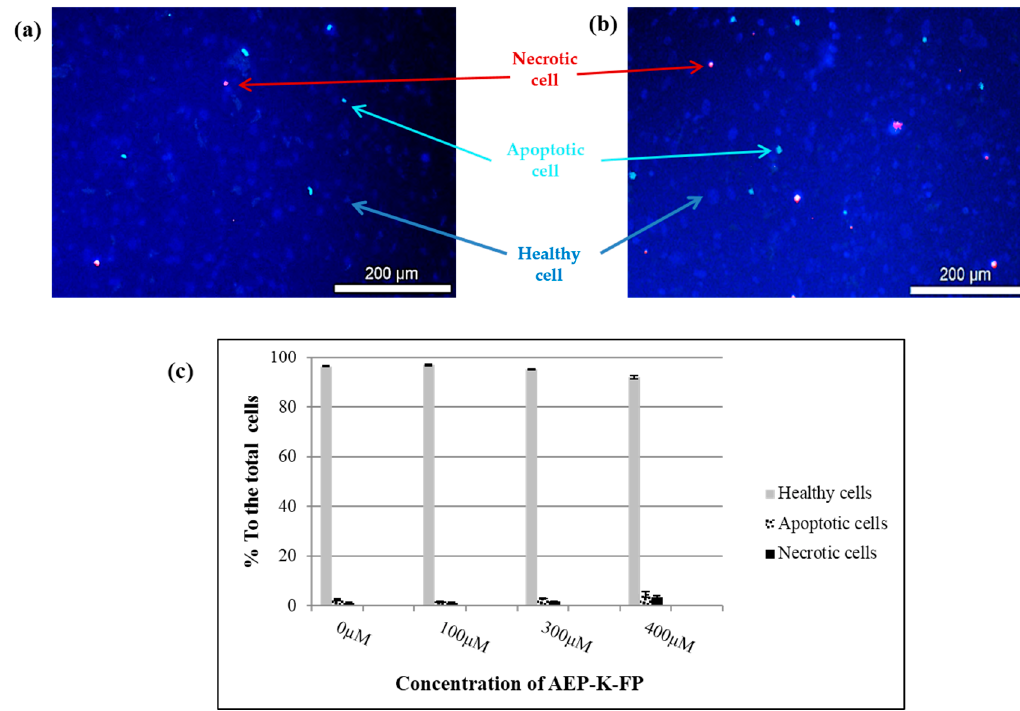
Figure 5. Examples of microscopic pictures after HPI staining. ( a ) Untreated cells (0 µ M). ( b ) AEP-K-FP (400 µ M). The blue cells represent the healthy living cells while the bright blue refers to apoptotic cells, and the red is necrotic cells. ( c ) The percentage of healthy, apoptotic, and necrotic cells to the total number of cells in each field with no significant di ff erences from the control ( P > 0.05). Data expressed as mean ± SD of n = 6.